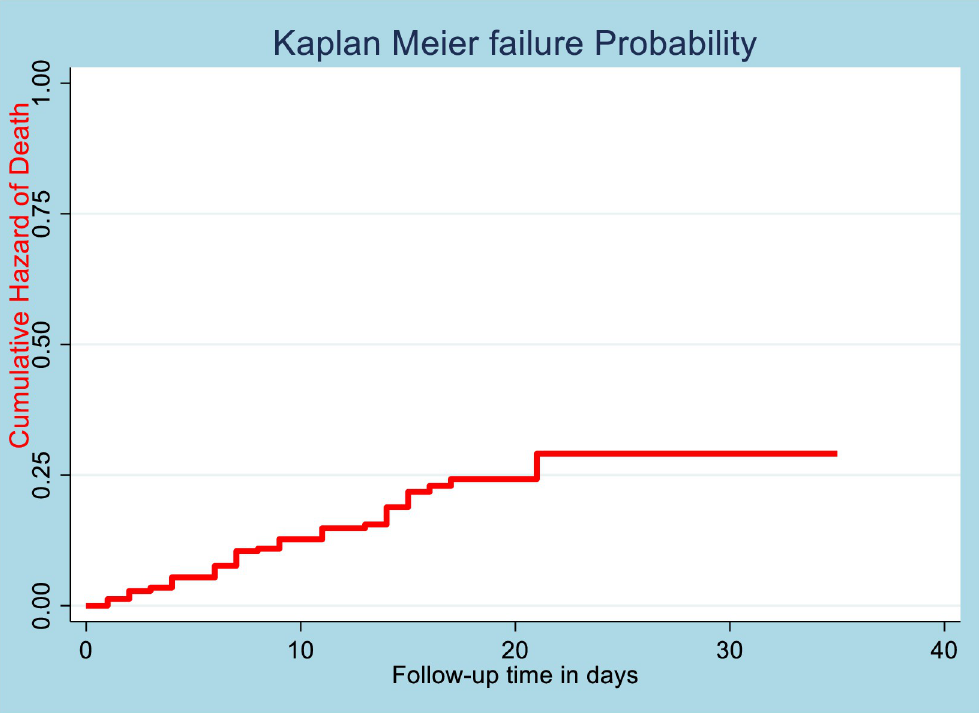
Fig 2. Overall Kaplan Meier failure probability